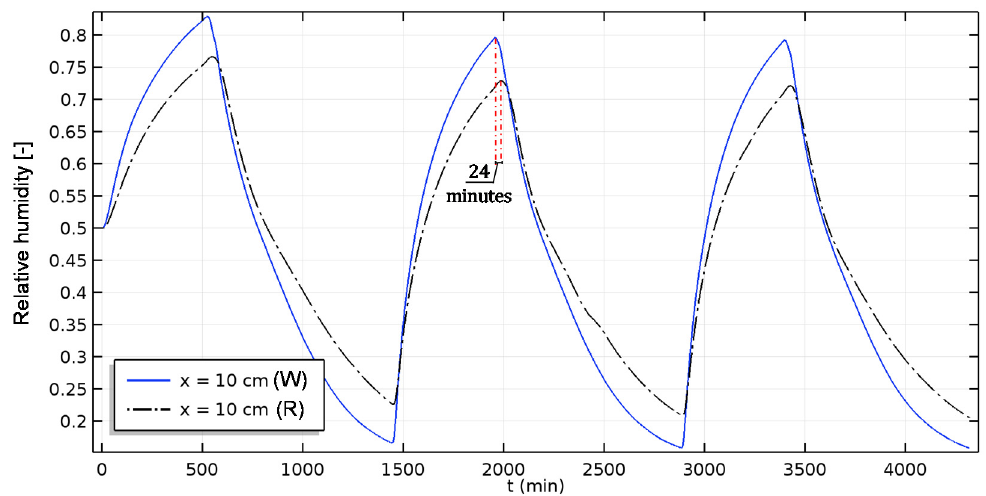
Figure 9. Isothermal case: Evolution of the relative humidity of aged and reference hemp concrete (W: Weathered; R: Reference).